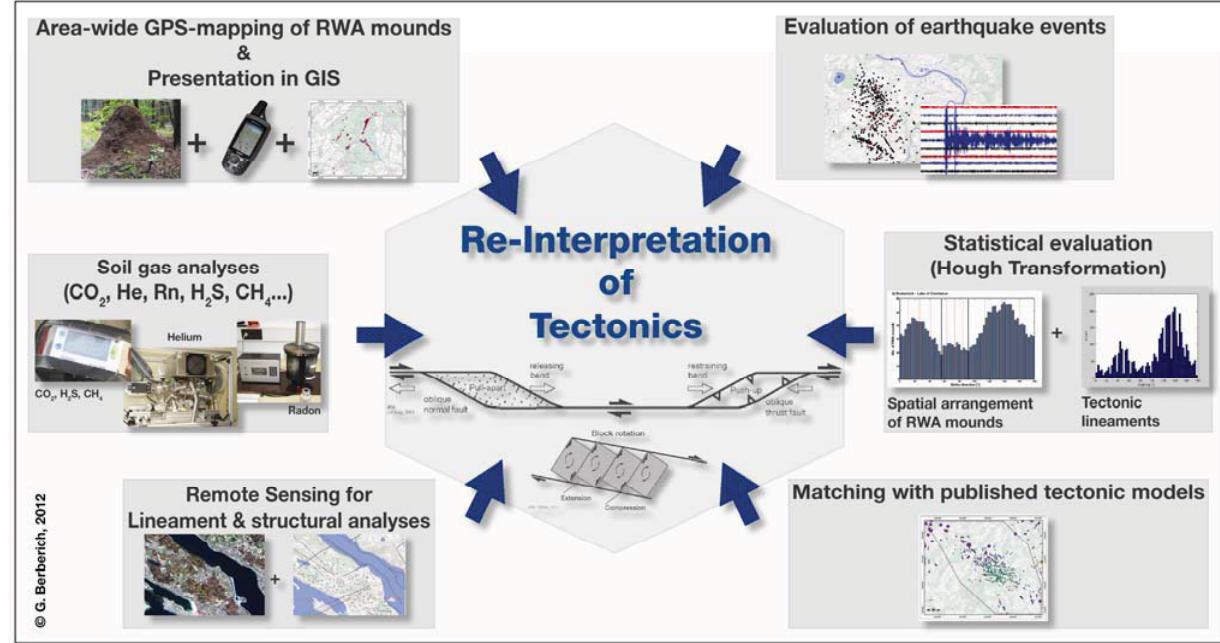
Figure 4. In a comprehensive GeoBioScience-approach, different methods were combined and applied to investigate the relationship between RWA mounds and active tectonic fault